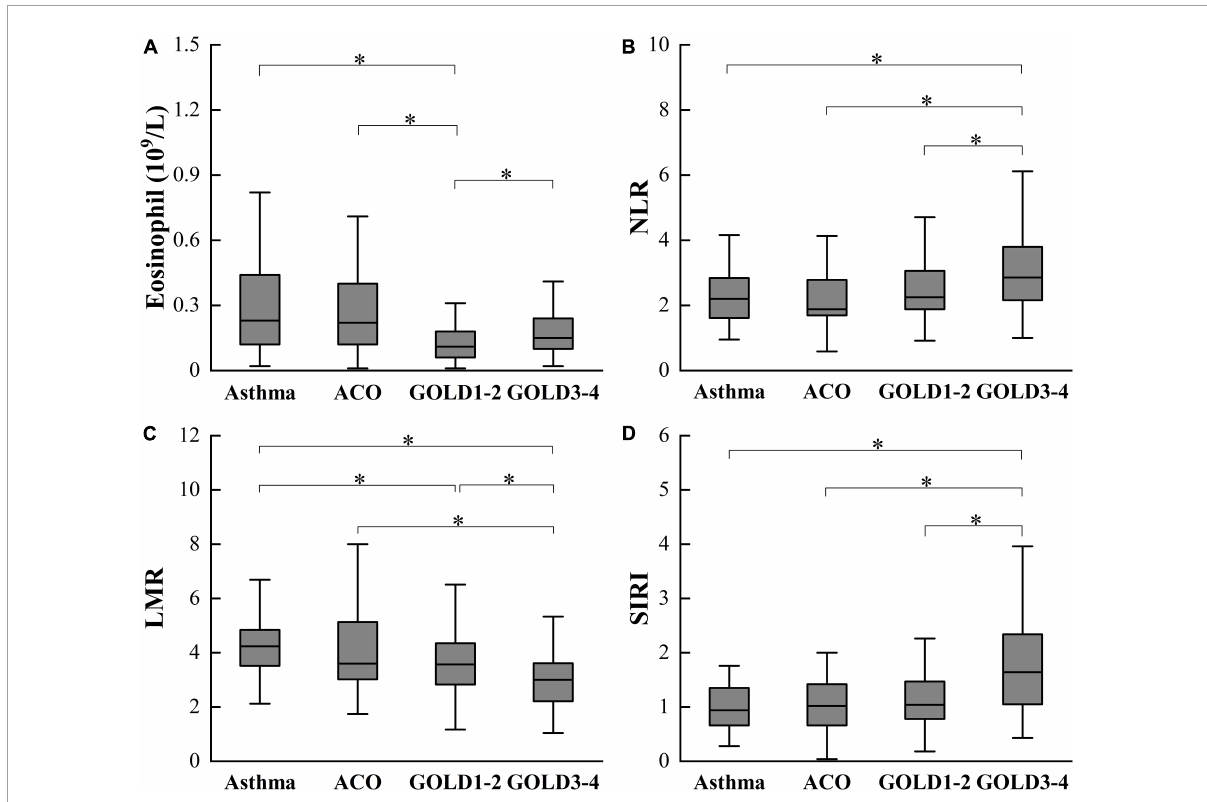
FIGURE1 Differences in eosinophil (A) , NLR (B) , LMR (C) , and SIRI (D) among asthma, ACO and COPD. ACO, asthma-COPD overlap; COPD, chronic obstructive pulmonary disease; GOLD, Global Initiative for Chronic Obstructive Lung Disease; NLR, neutrophil-lymphocyte ratio; LMR, lymphocyte-monocyte ratio; SIRI, monocyte × neutrophil/lymphocyte. * P <